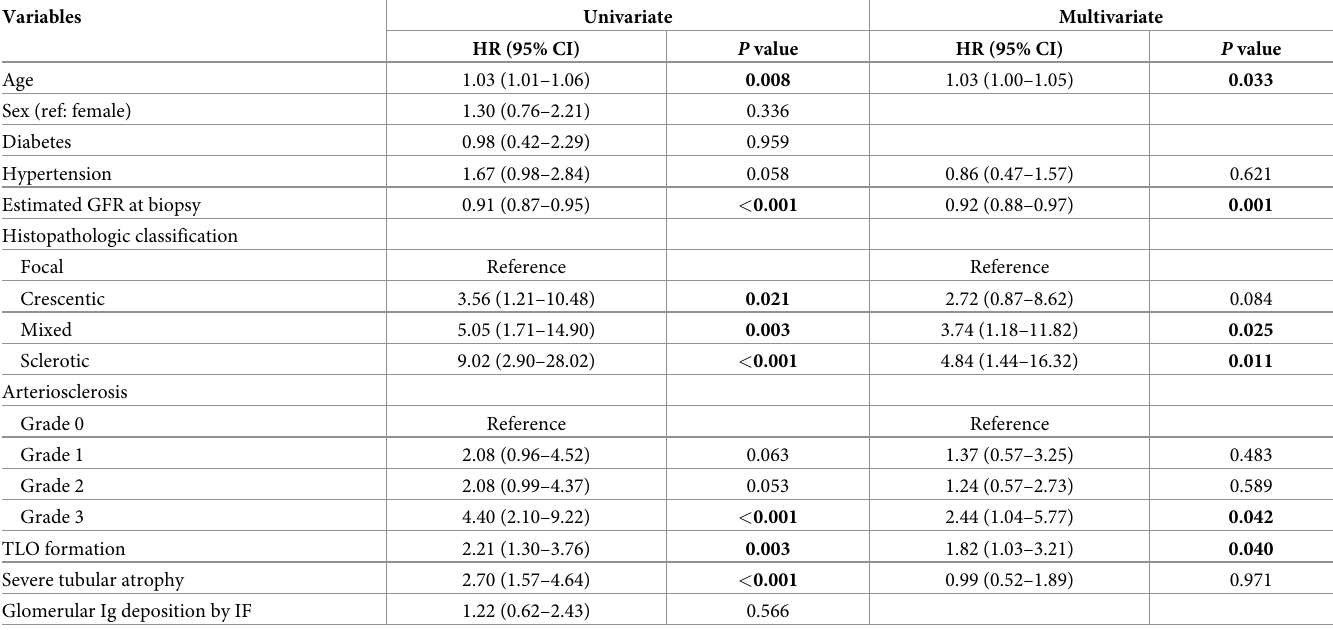
Table 3. Predictors for renal survival in Cox proportional hazards